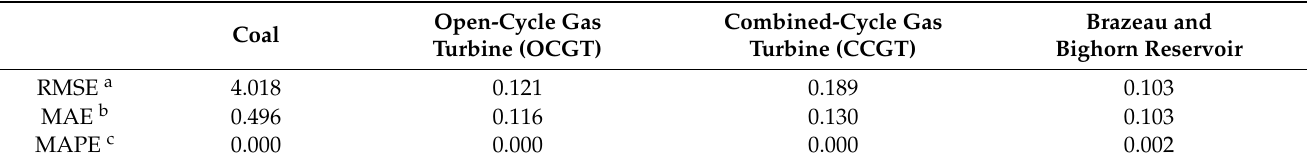
Table 3. Differences between Calibrated and Observed Outputs for Four Generator Types, based on the Second Calibration